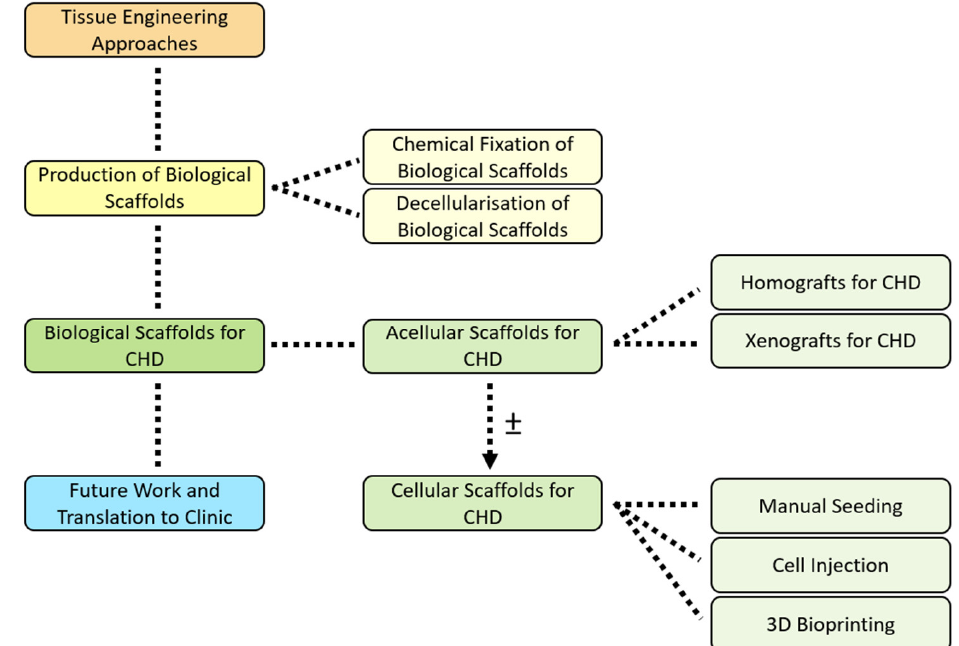
Figure 1. Schematic of review structure.